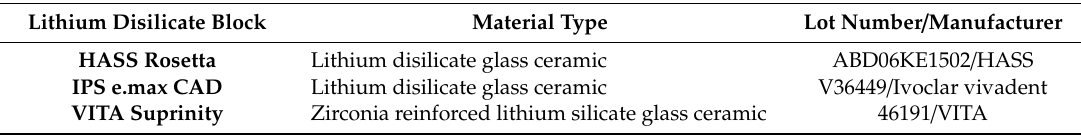
Table 1. Datasheet of lithium disilicate block testing.